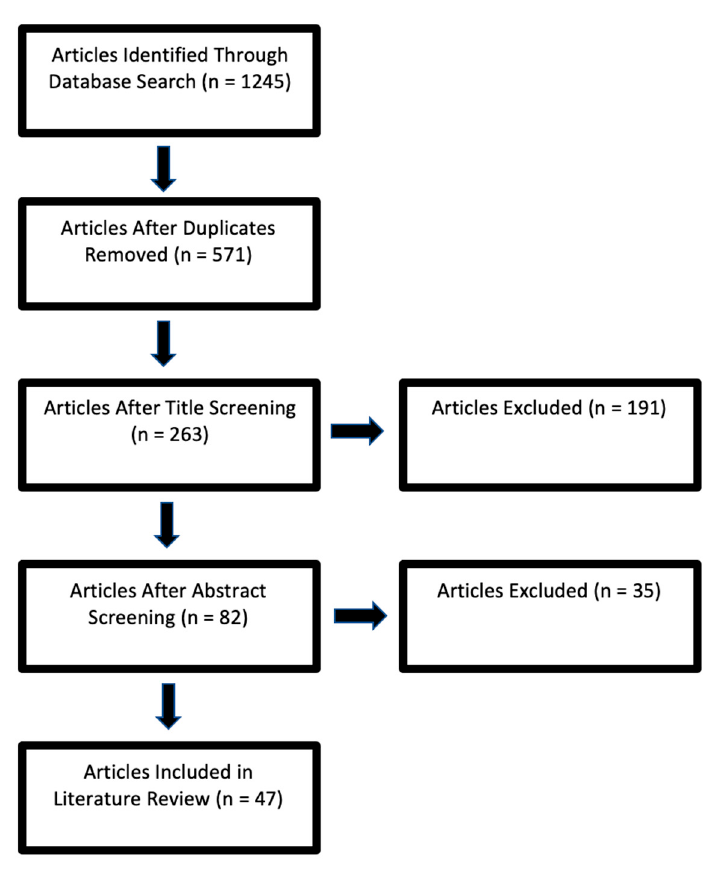
Figure 1. Flowchart for inclusion of articles in the literature review.